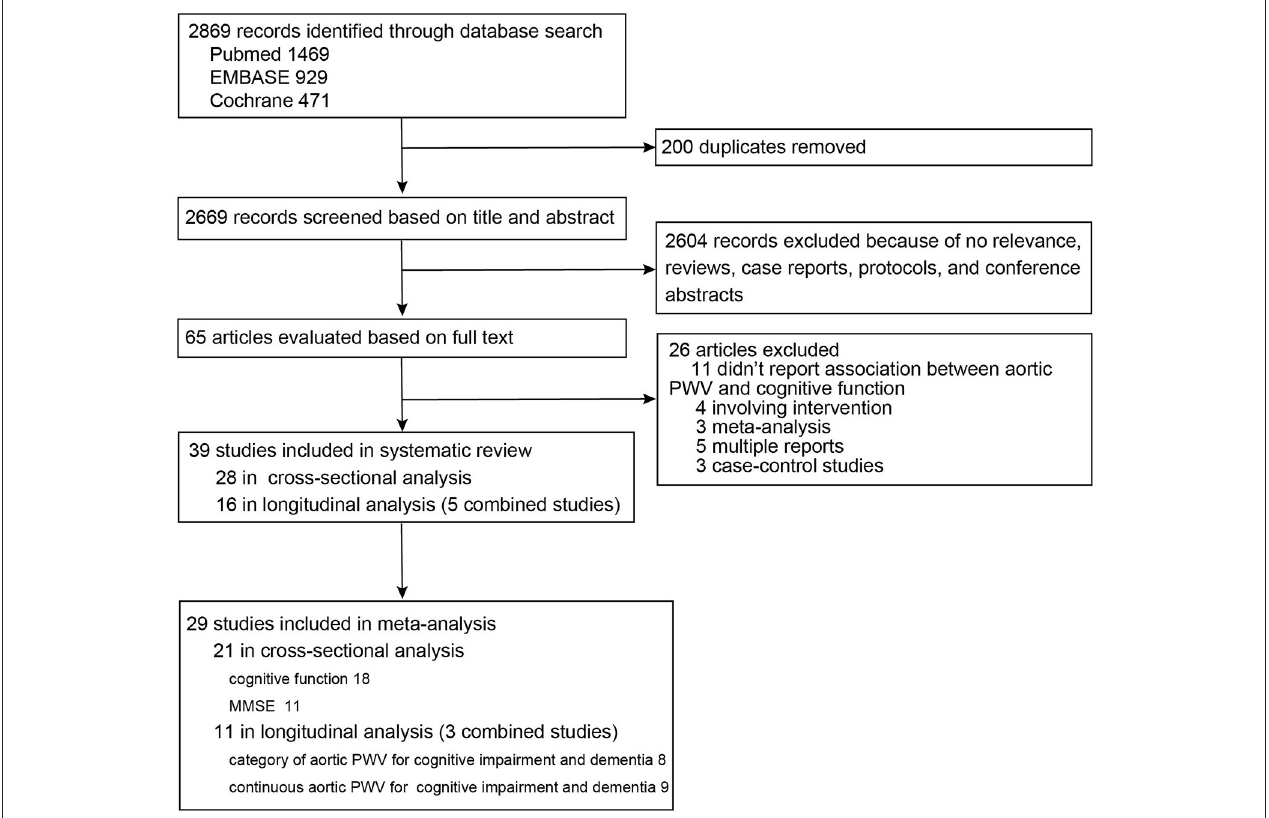
FIGURE 1 | Flow diagram of study selection for systematic review and